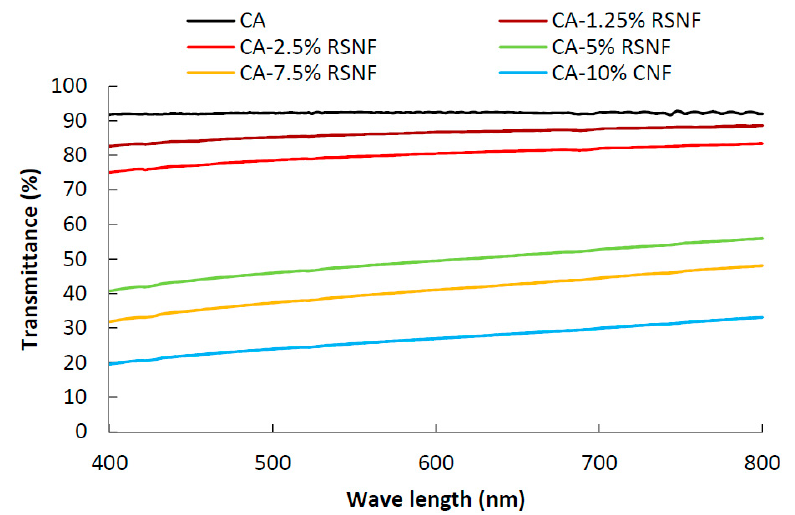
Figure 5. Visible light transmittance of CA films containing different ratios of RSNF.